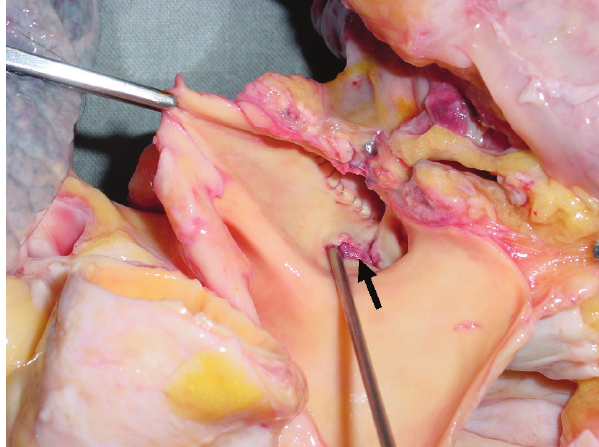
Figure 3 - Autopsy examination of the bronchovascular fistula orifice through the pulmonary